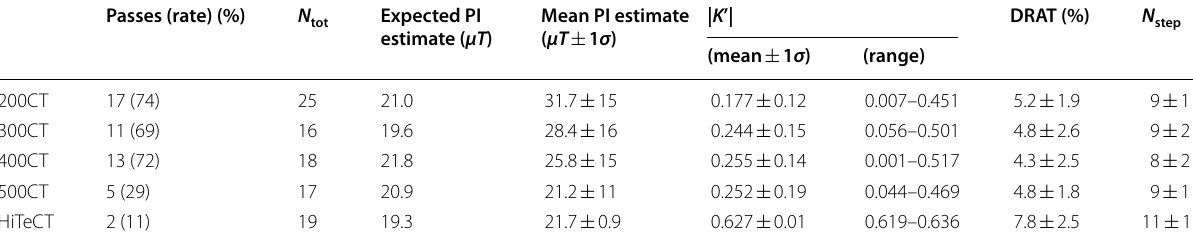
N tot is the total number of specimens run, PI means paleointensity, | K ’| is a measure of curvature of the points selected on an Arai plot, and N step is the mean number of Arai plot data points selected